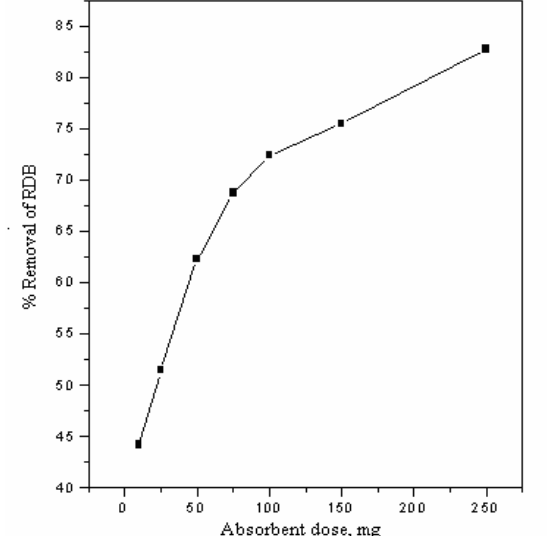
Figure 2 . Effect of absorbent dose on the removal of RDB by PSC [RDB]=30 mg / L; contact time = 90